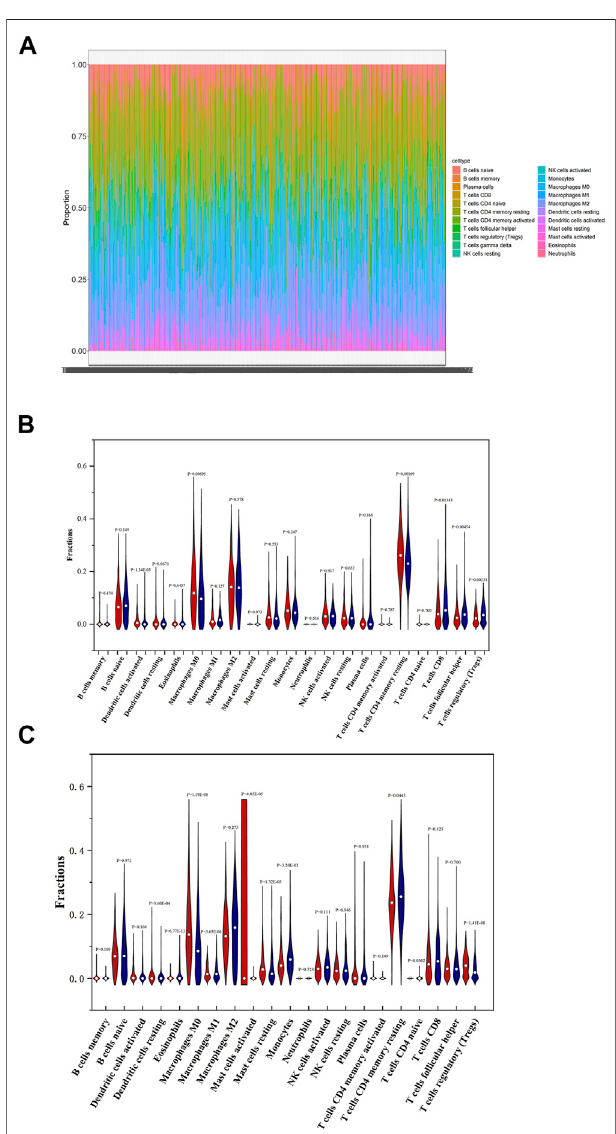
FIGURE 9 | Immune landscape in low and high-risk patients with PTC. (A) Proportions of 22 immune cells in PTC patients. (B) Comparisons on the proportions of immune in fi ltrating cells between low and high-risk patients basedonOS-associatedsignature. (C) Comparisonsontheproportions of immune in fi ltrating cells between low and high-risk patients based on DFS- associated signature.